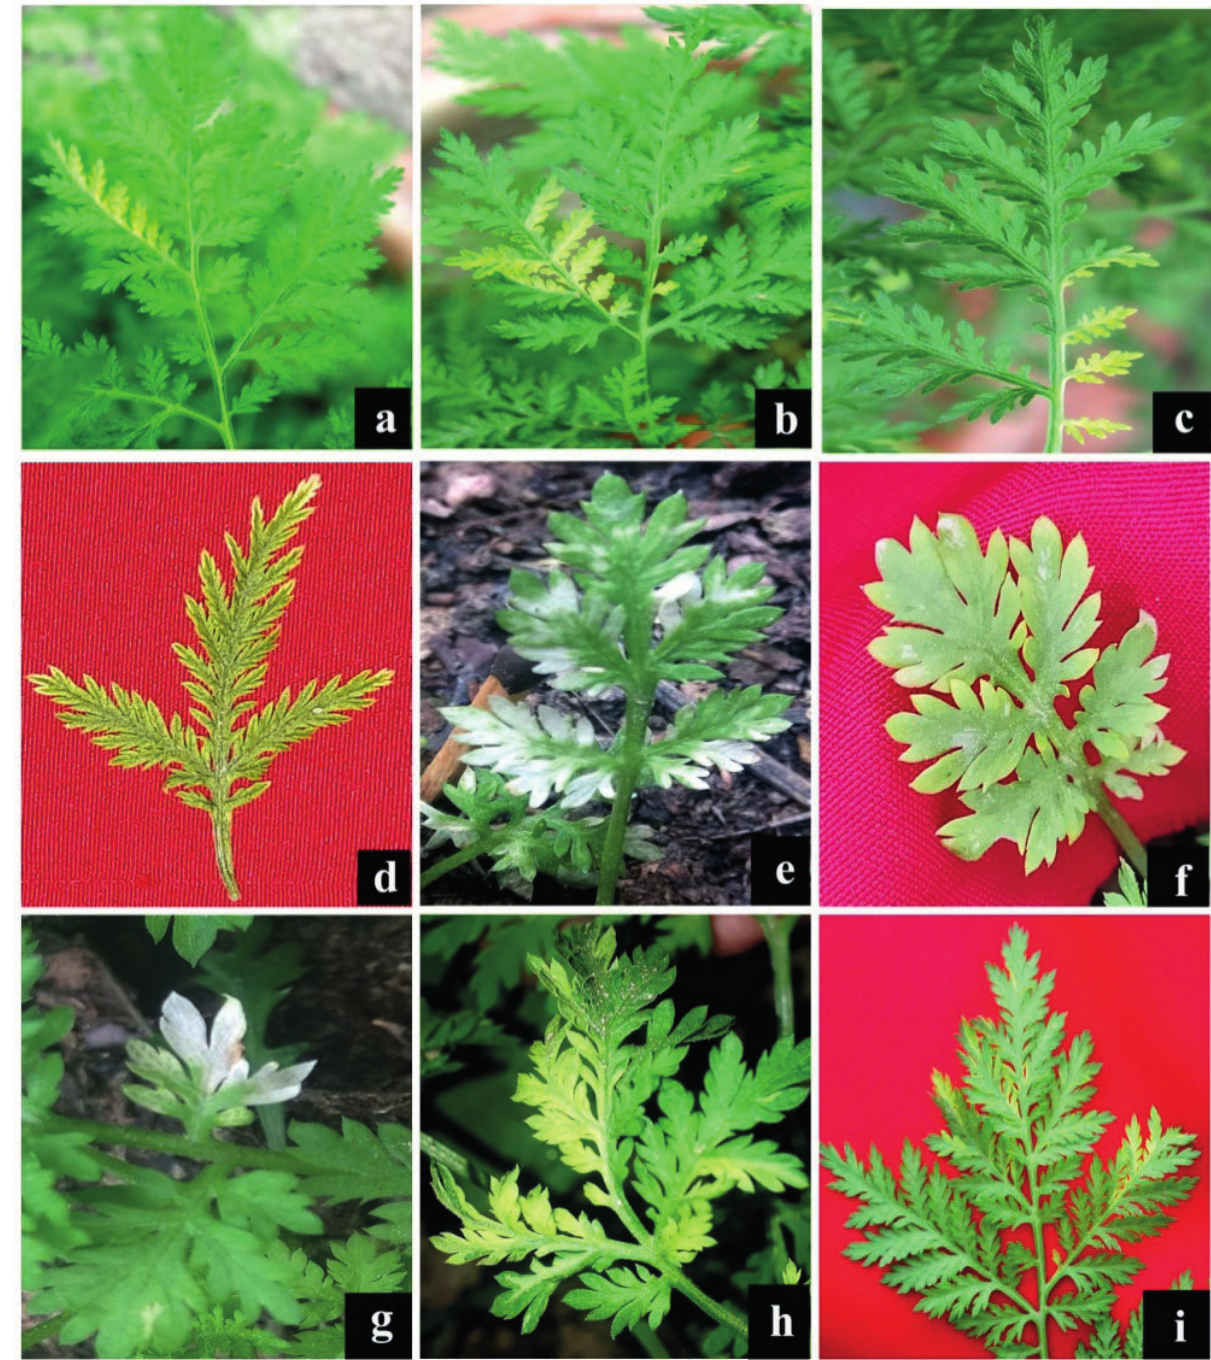
Figure 4. Different types of chlorophyll mutants in Artemisia annua L. a. b. c. Chlorina mutant, d. Tigrina mutant, e. g.. Albina mutant, f. maculate mutant, h. i. Yellow viridis